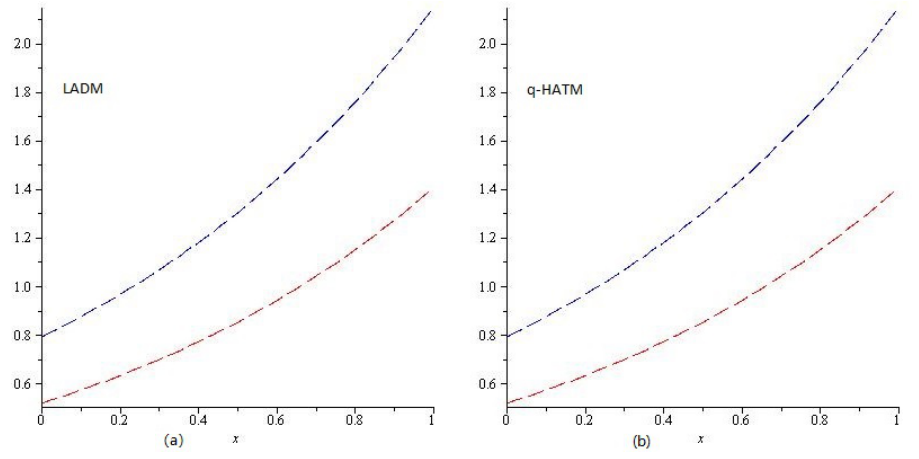
Figure 3. The comparison plots at γ = 0.75 and